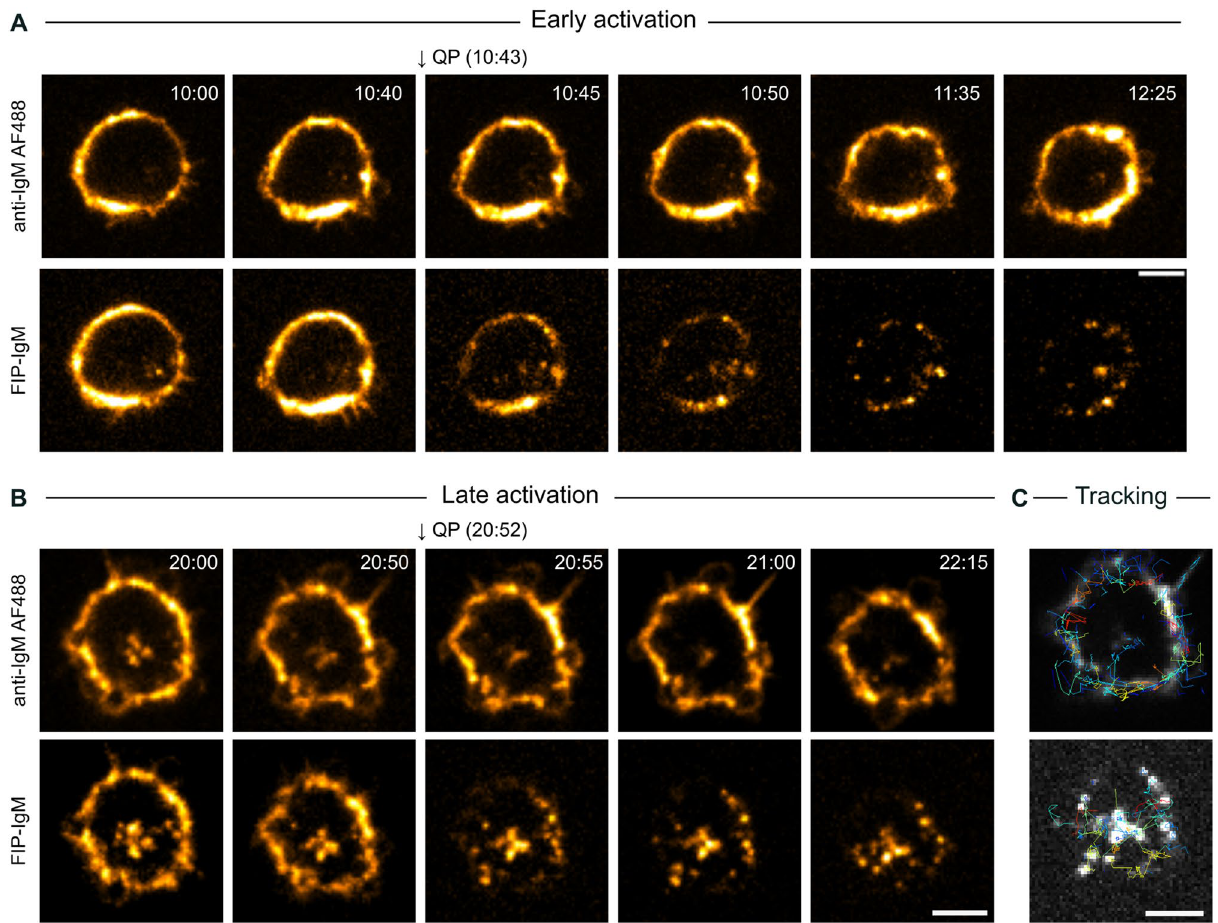
Figure 3. The SHIP assay improves live cell imaging of antigen trafficking. (A-B) B cells were attached to a fibronectin-coated dish and engaged on ice with ATTO-FIP-IgM and Alexa Fluor 488 anti-IgM. Cells were transferred to 37 °C for ( A ) 10 min or ( B ) 20 min, for antigen/receptor endocytosis. The recording was started and after 40–60 s QP was added to the cells without interrupting image acquisition. QP addition is indicated with an arrow. Images were acquired using a SDCM (one slice, one frame every 5 s). Time in minutes after triggering endocytosis is indicated in the top-left corner. LUT (Look Up Table) Hot Yellow. ( C ) Antigen tracking after quenching was performed using TrackMate. The antigen tracks (blue for shorter and red for longer) are shown in the image. Scale bar: 5